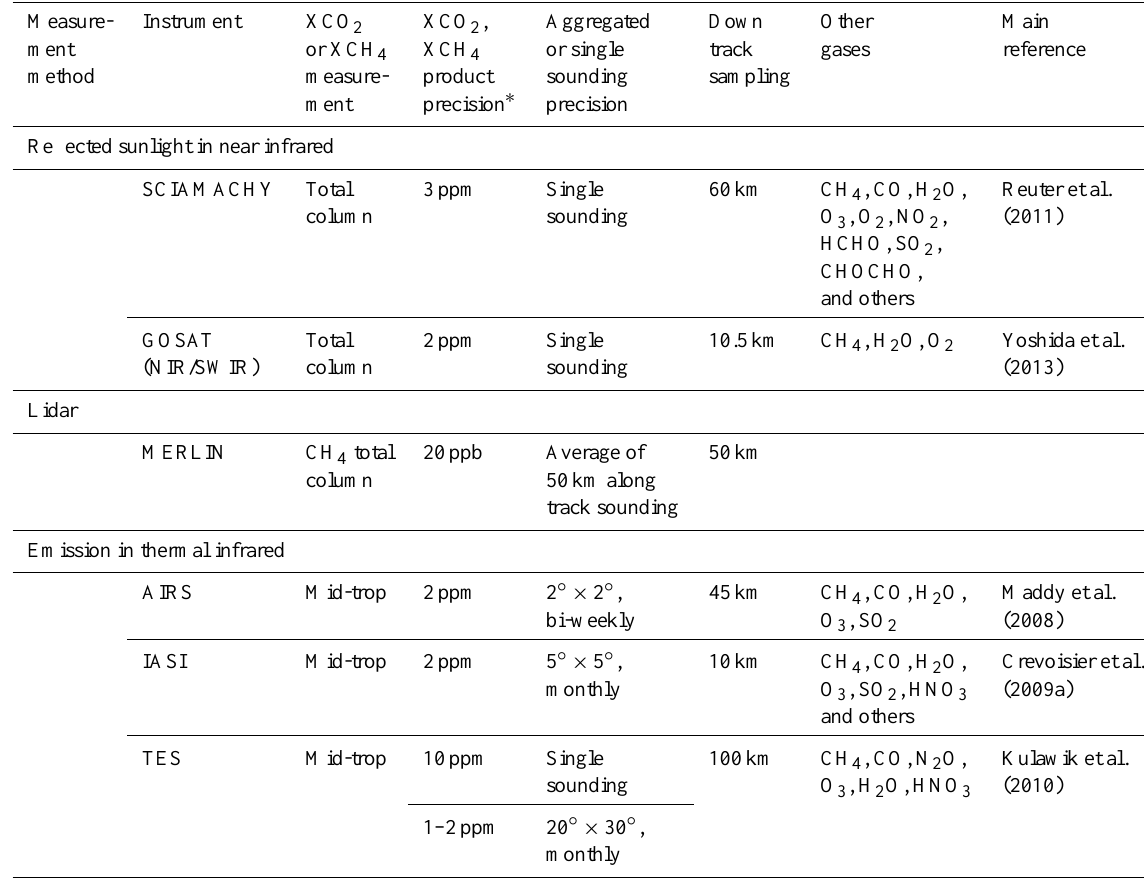
Table 1. Measurement methods for CO 2 and CH 4 column measurements from space borne sensors, with precisions, sampling, and species